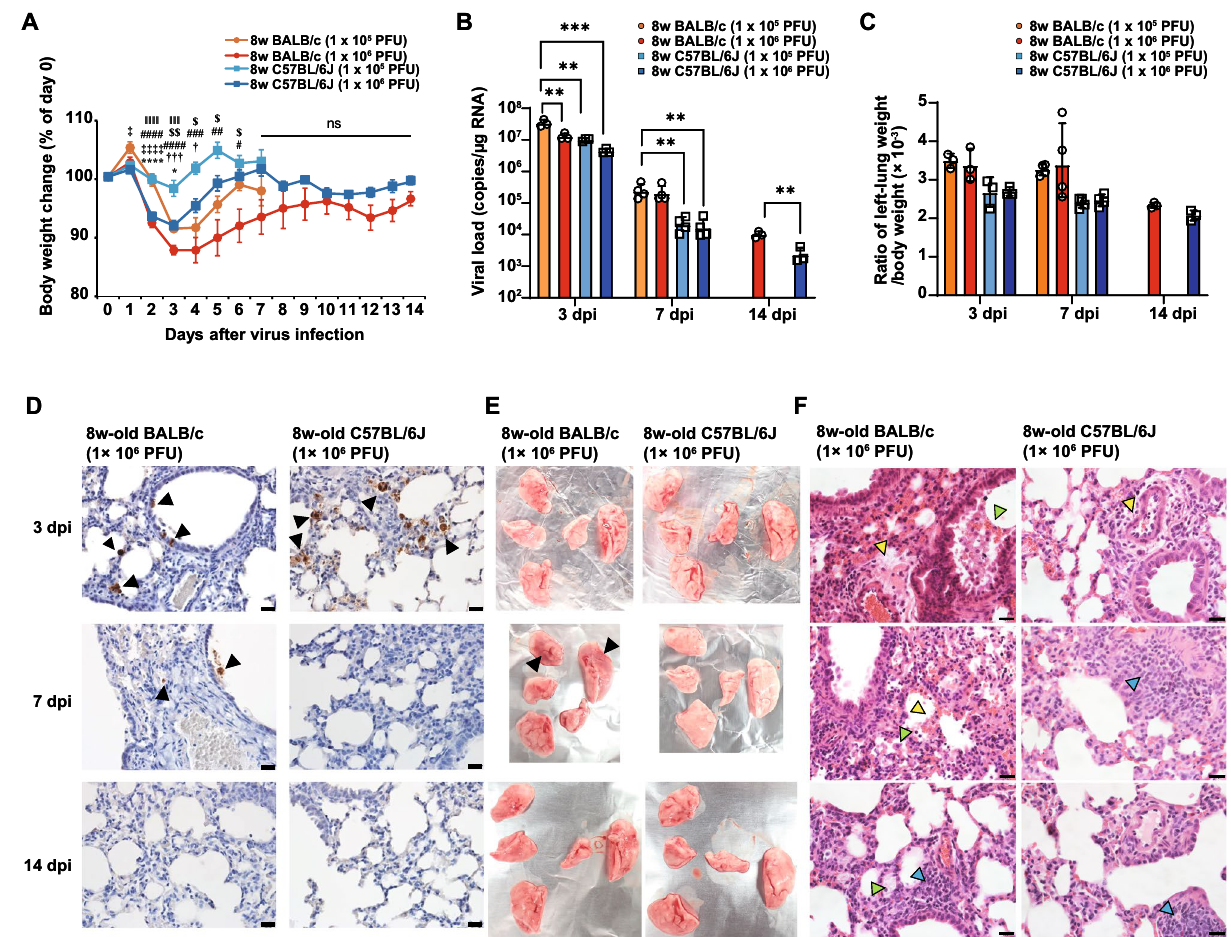
Figure 1. BALB/c mice showing severer symptoms than C57BL/6 J mice after infection by the SARS-CoV-2 B.1.351 variant (TY8-612 strain). ( A ) Mean body weight changes over 14 days after exposure to the TY8-612 strain. Each value represents a mean ± SEM of n = 3–10. P values were calculated via one-way-ANOVA followed by Tukey’s test, with p < 0.05 considered significant. Symbols indicate significant differences: *, between 1 × 10 5 PFU of TY8-612-infected BALB/c and 1 × 10 6 PFU of TY8-612-infected BALB/c. †, between 1 × 10 5 PFU of TY8-612-infected BALB/c and 1 × 10 5 PFU of TY8-612-infected C57BL/6 J. ‡, between 1 × 10 5 PFU of TY8-612- infected BALB/c and 1 × 10 6 PFU of TY8-612-infected C57BL/6 J. #, between 1 × 10 6 PFU of TY8-612-infected BALB/c and 1 × 10 5 PFU of TY8-612-infected C57BL/6 J. $, between 1 × 10 6 PFU of TY8-612-infected BALB/c and 1 × 10 6 PFU of TY8-612-infected C57BL/6 J. ‖ , between 1 × 10 5 PFU of TY8-612-infected C57BL/6 J and the SARS-CoV-2 N protein gene in 3–4 mice at each time point following intranasal infection with the TY8-612 strain (1 × 10 5 or 1 × 10 6 PFU/head). P values were calculated via two-tailed unpaired one-way-ANOVA followed by Tukey’s test. ( C ) Ratio of wet left-lung weight to the initial bodyweight (day 0) compared among groups. ( D – E ) Data of 8-week-old BALB/c and C57BL/6 J mice infected with 1 × 10 6 PFU of the T Y8-612 strain. ( D ) Detection of virus-infected cells in the lungs at 3, 7, or 14 dpi (SARS-CoV-2 N protein [brown staining, original magnification 400 × , scale bar = 20 μm]). Black arrowheads indicate infected cells. Nuclei were stained with hematoxylin. (E) Lung macroscopic appearance at indicated days. Black arrowheads indicate lesions in dark red. ( F ) Representative lung sections (hematoxylin and eosin staining, section thickness of 4 μm) from 8-week- old BALB/c and C57BL/6 J mice at 3, 7 or 14 dpi. The original magnification is 400 × for all micrographs (scale bar = 20 μm). Yellow arrowheads indicate perivascular edema (upper panels), hemorrhage, and congestion (left middle panel). Light green arrowhead indicates activated macrophage infiltration (left panels). Light blue arrowheads indicate lymphoid infiltration (left lower, right middle, and right lower